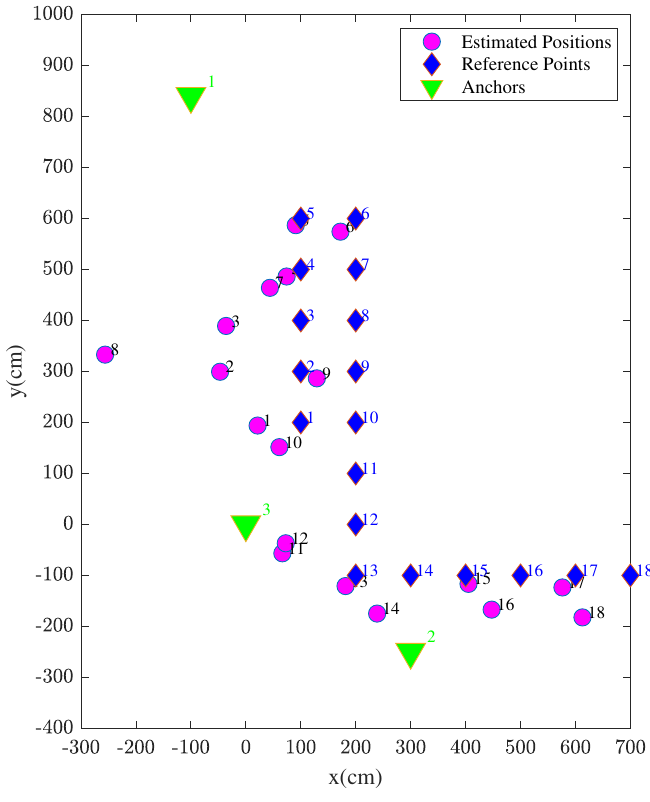
Figure 15. UE positions estimated using standalone Ultra Wide Band (UWB)